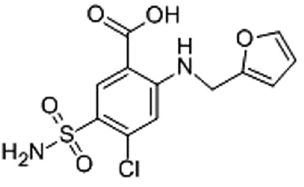
Figure 1: Chemical structure of